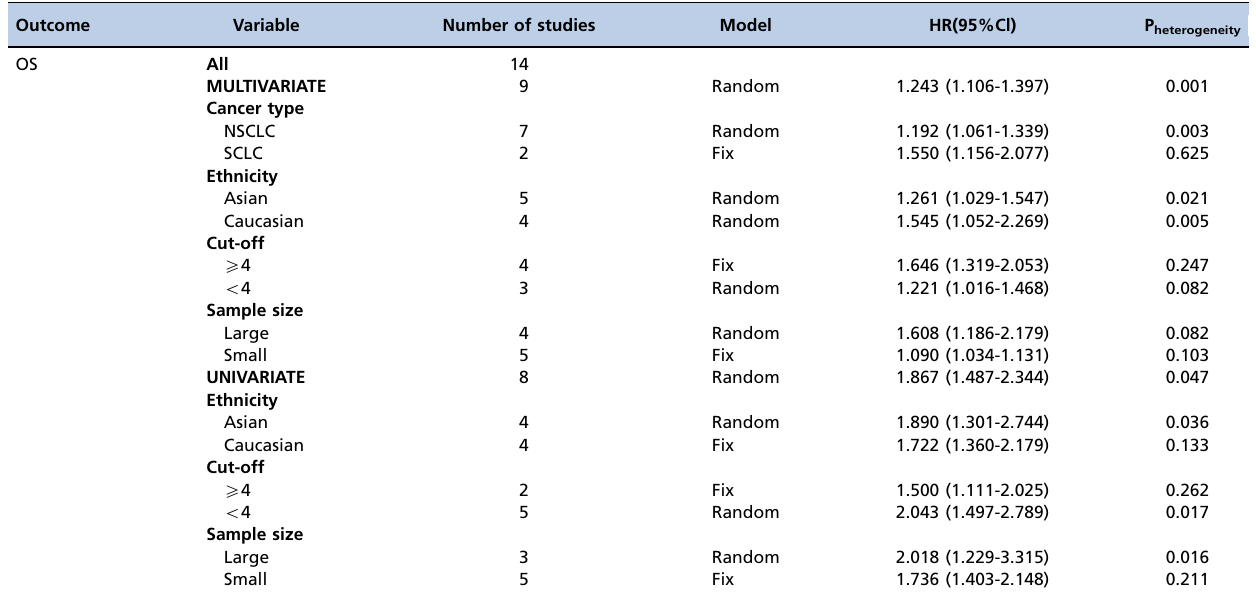
Table 2 - Meta-analysis